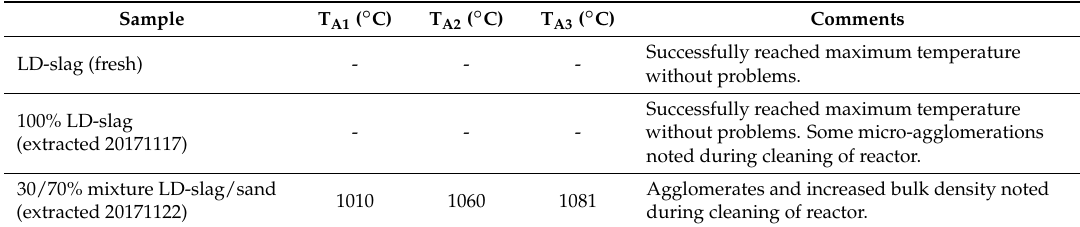
Table 5. Results of agglomeration